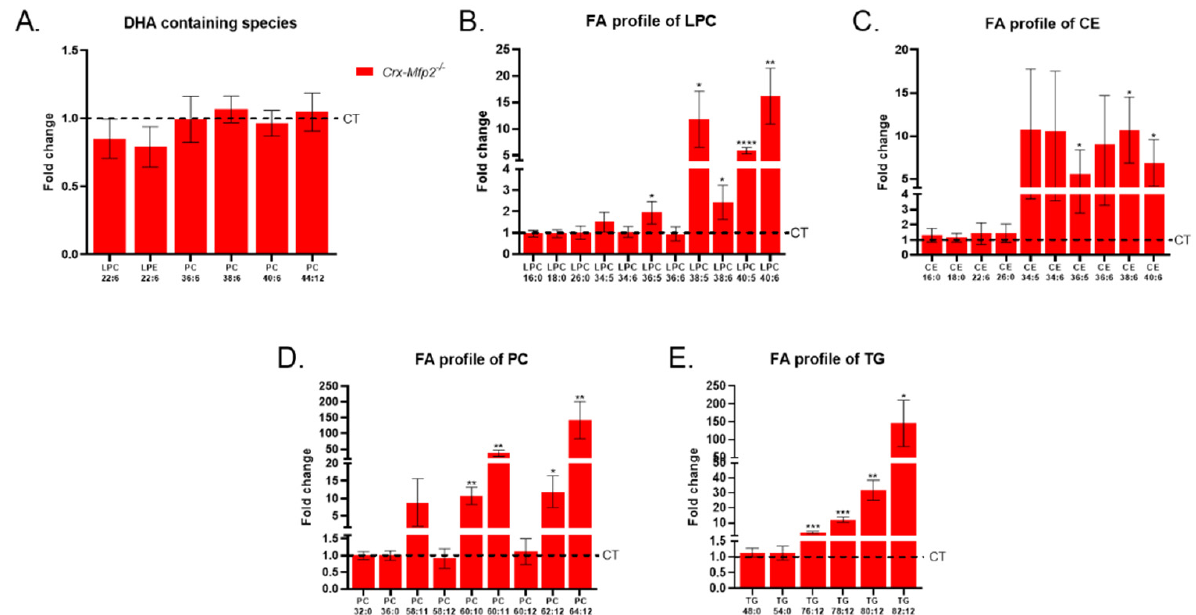
Figure 3. PUFA levels in the neural retina of 6-month-old Crx-Mfp2 − / − mice. ( A ) DHA levels were not altered in the neural retina of Crx-Mfp2 − / − mice. However, VLC-PUFAs accumulated in lysophos- phatidylcholine ( B ), cholesterol esters ( C ), phosphatidylcholine ( D ) and triglycerides ( E ). Data are presented as fold change compared to CT levels. CT levels are presented as a dashed line. N =